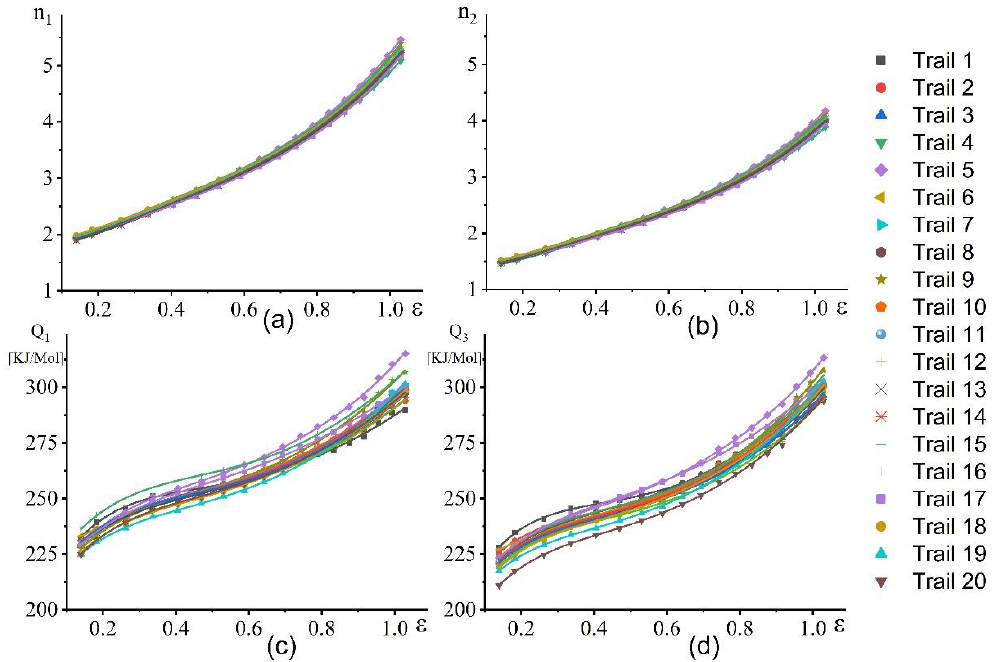
Figure 12. Variation of n1, n2, Q1, and Q3 with true strain for all trails: ( a ) n 1 , ( b ) n 2 , ( c ) Q 1 , and ( d ) Q 3 .